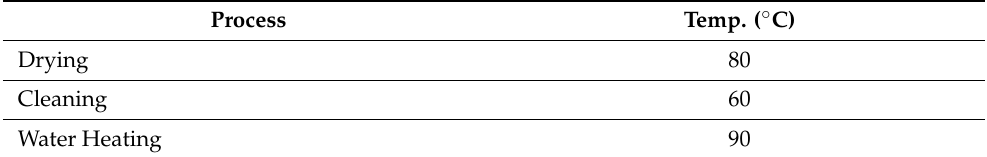
Table 8. Agriculture process requirements [116].